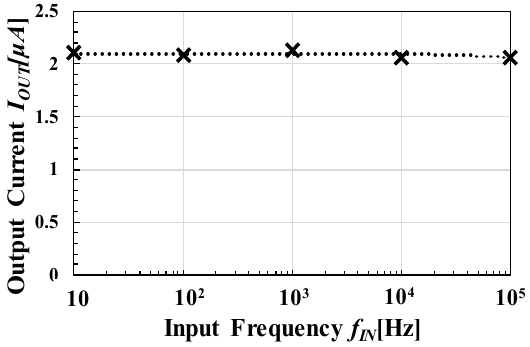
Figure 17. Measured I OUT as a function of f IN ( V DD = 0.5 V, V OUT = 2 V, f CLK = 5 MHz).